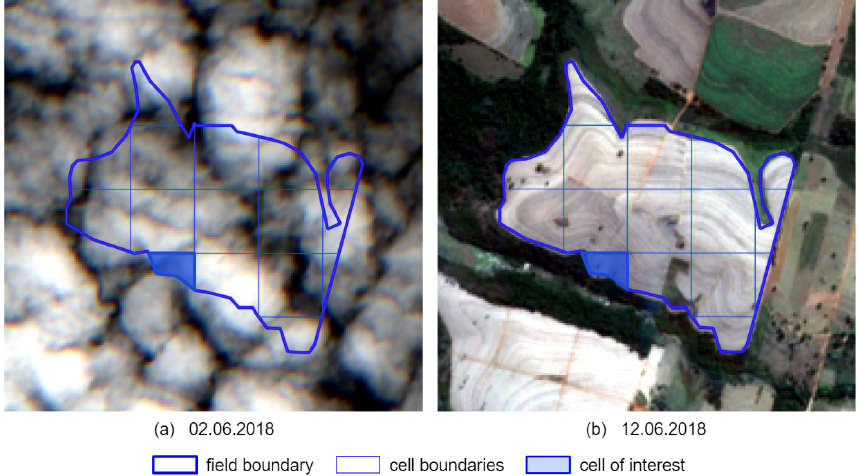
Figure 17. ( a , b ) Example of the cloudiness effect during the harvest period